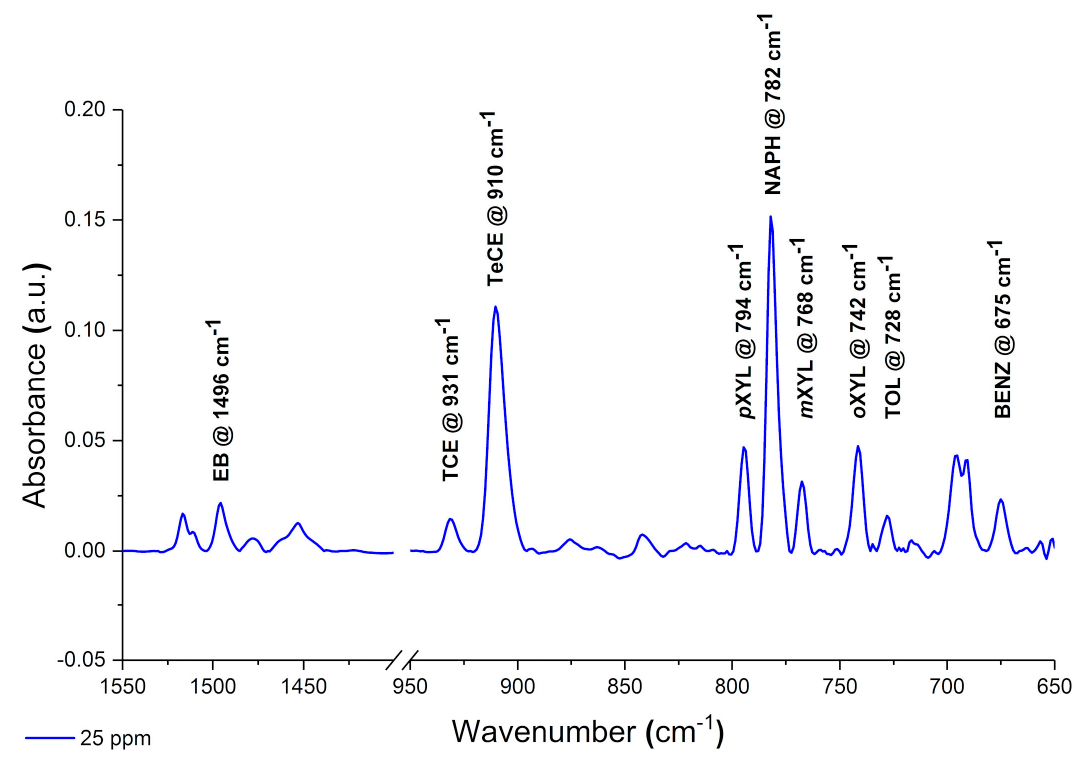
Figure 2. Exemplary ATR-FTIR spectrum of nine simultaneously detected VOCs in deionized water recorded with a fluorine-terminated DLC-coated Si wafer and an E/P-co polymer coating after 25 min of diffusion/enrichment. The IR absorption features do not overlap; therefore, univariate analysis was applied.